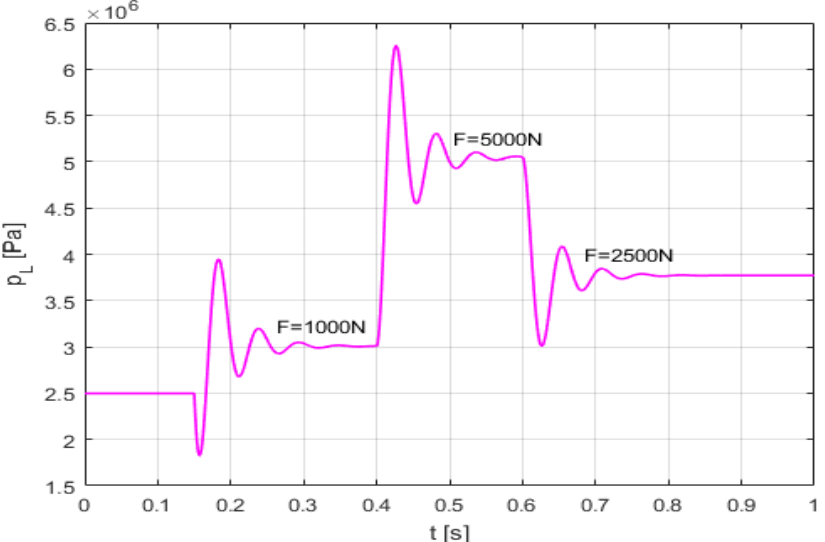
Figure 15. Comparison of the dynamic responses of the shock pressure p L ( t ) of an SHA damped by an HSD with the shock force of irregular appearance F .